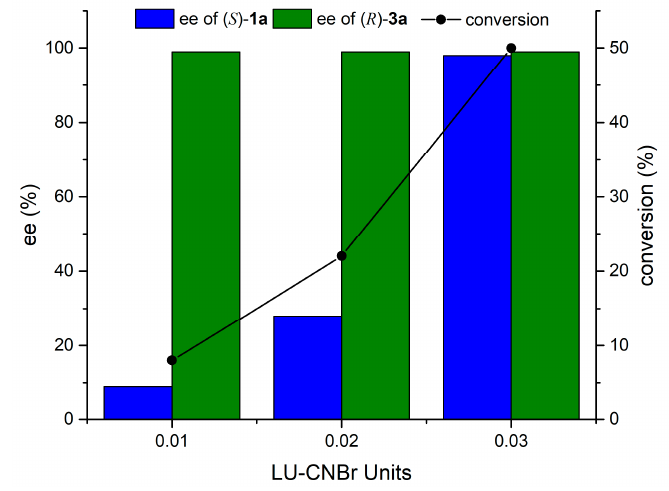
Figure 1. Effect of the cyanogen bromide (LU ‐ CNBr) dose on the substrate conversion and optical purity of the products of kinetic resolution of racemic alcohol 1a in the process of transesterification with vinyl propionate (24 h reaction in diisopropyl ether).